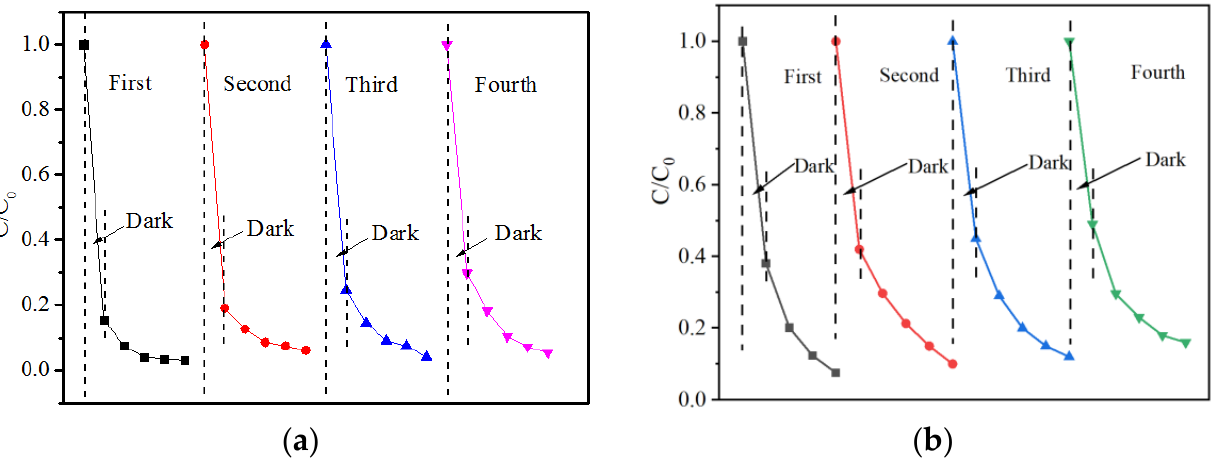
Figure 4. Cycling experiments of B-TiO 2 /C 3 N 4 for the adsorption – photocatalytic degradation of MB ( a ) and RhB ( b ).